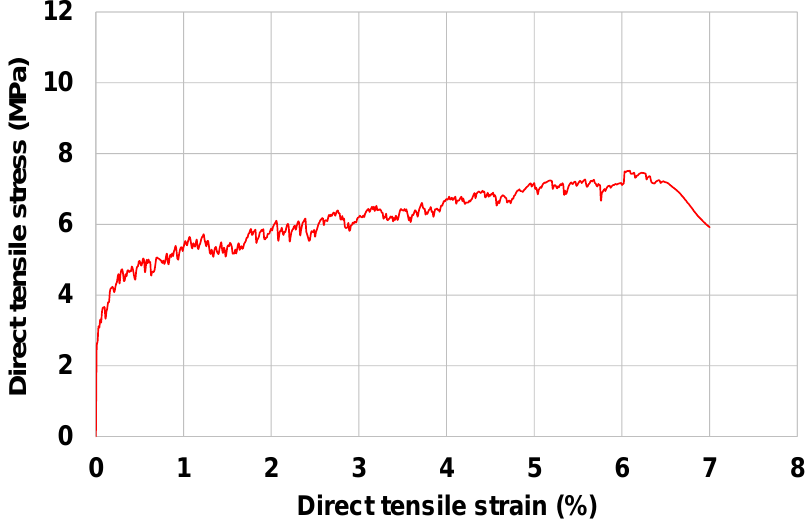
Figure 2. Direct tensile stress–strain curve of URH-FRM. Table 3. Experimental